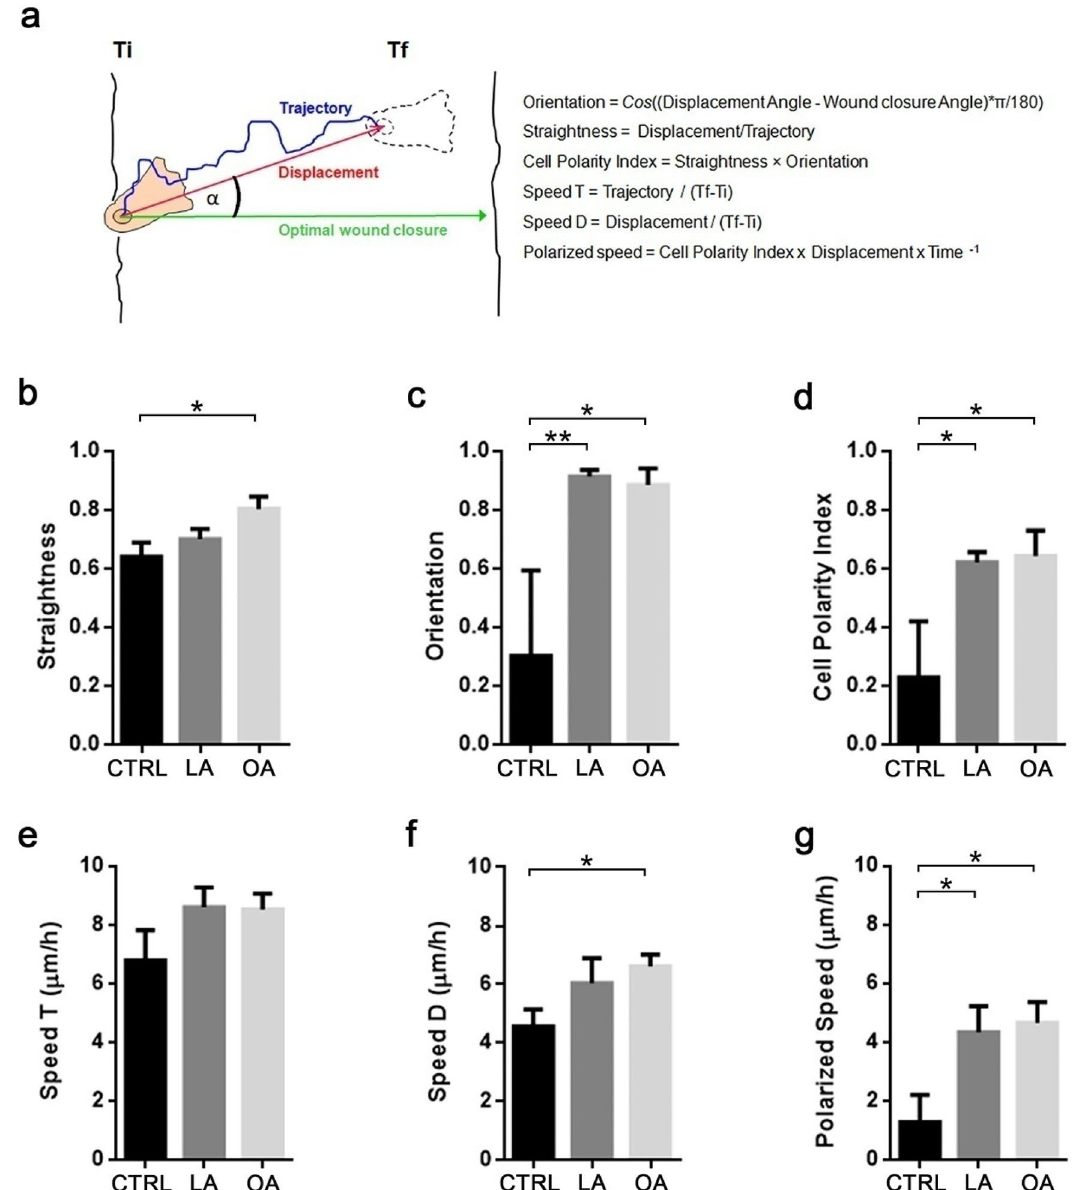
Figure 2. LA and OA enhanced cell orientation and polarity during migration. ( a ) The diagram depicts the variables measured and calculated of cell movements during the time lapse of the video imaging: straightness ( b ), orientation ( c ) and cell polarity index ( d ). Speed taking into account the cell trajectory ( e ), displacement ( f ) and integrative index polarized speed ( g ). Plots show mean ± SEM and asterisks represent statistically significant differences by Students t-test (*p < 0.05, **p < 0.01). Data obtained from 10 to 15 trackings per